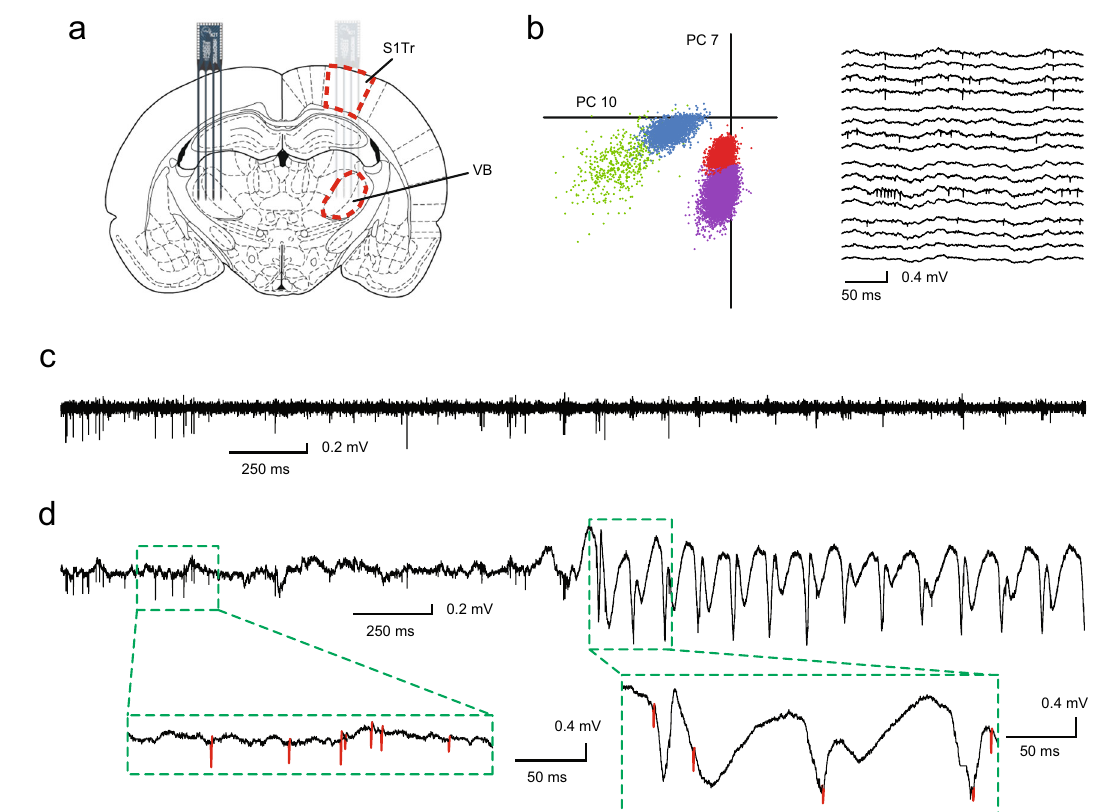
Fig. 3 | Recording of individual neuronal action potentials in the cortex and thalamus of freely moving rats. a Rat brain coronal section at bregma − 3.6mm (reproduced with permission from Paxinos & Watson Rat Brain Atlas 91 ) indicating target locations of primary somatosensory trunk cortical (S1Tr) and ventrobasal thalamic (VB) electrode arrays. b Example principal component values of wave- forms from simultaneously recorded cortical neurons (left) and sample raw broadband (1.1Hz – 7.6kHz) voltage traces from a 16 channel array (right) from whichneuronactionpotentialswereextracted.Recordingshowsdataduringanon- seizure baseline period. PC7 and PC10 represent the fi rst principal components